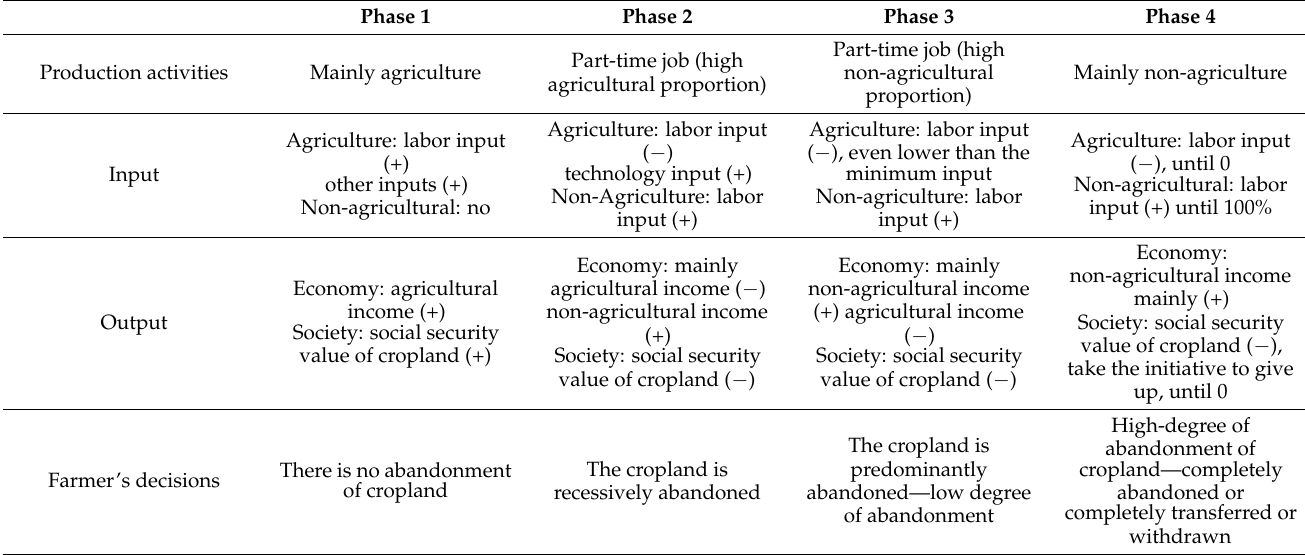
Table 3. Evolution process of cropland abandonment for